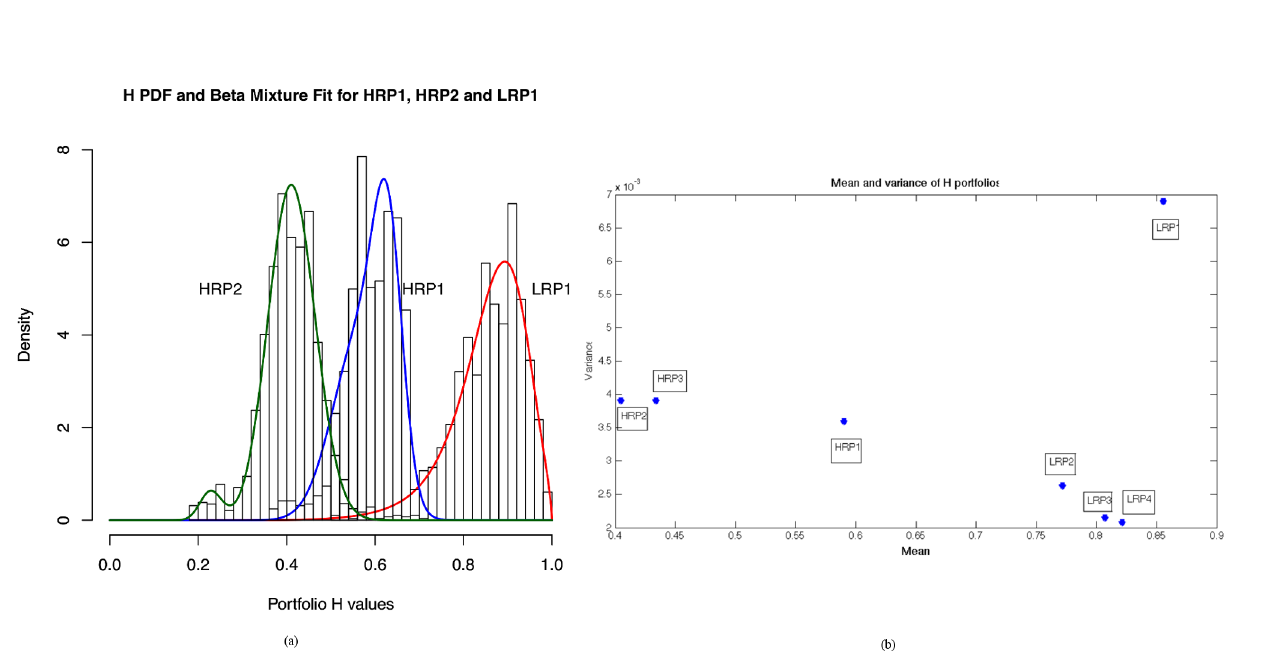
Fig 5. (a) Mixture of beta distribution fit to the Hölder exponent of High Risk Portfolio 2, High Risk Portfolio 1, and Low Risk Portfolio 1. (b) Mean and variance of the beta mixture distribution for the seven portfolios.